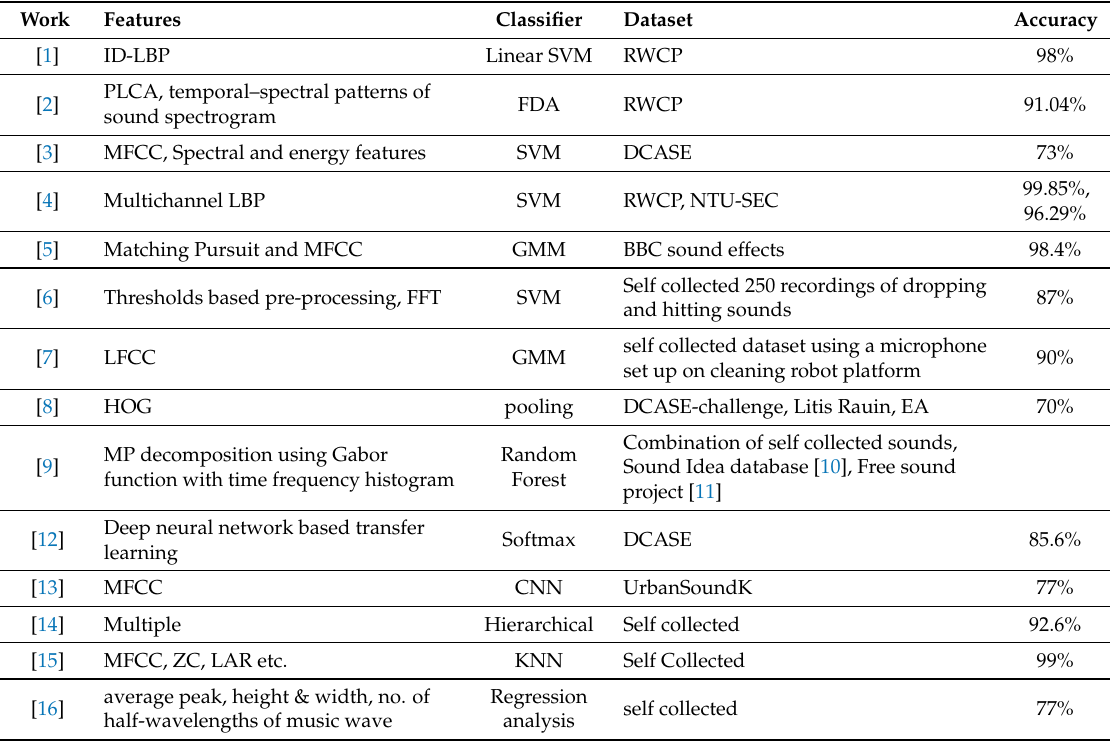
Table 1. Summary of published works on acoustic scene